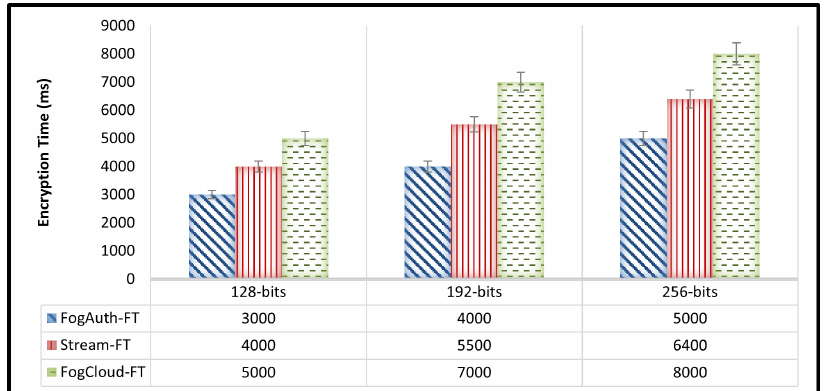
Figure 11. Comparison of computational resources